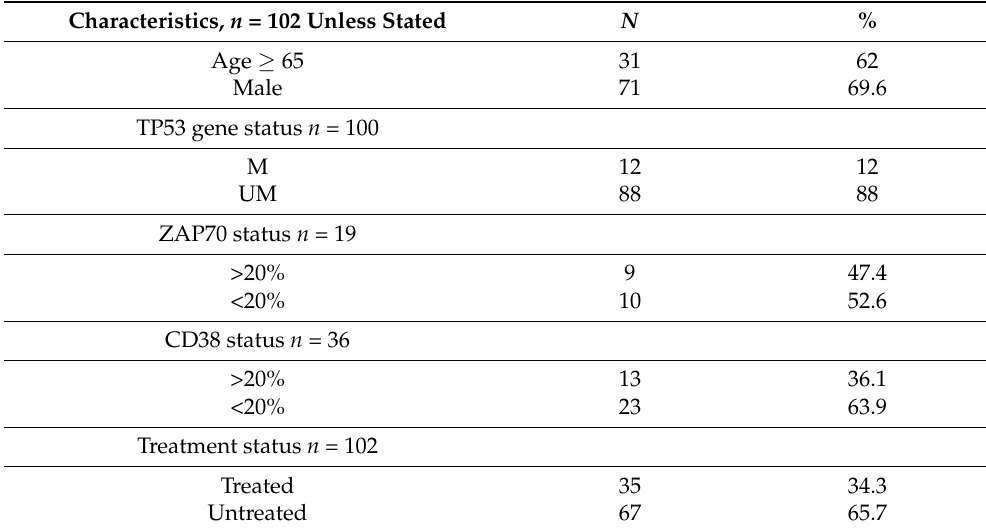
Table 1. Clinical and molecular characteristics of the CLL cohort. Characteristics, n = 102 Unless Stated